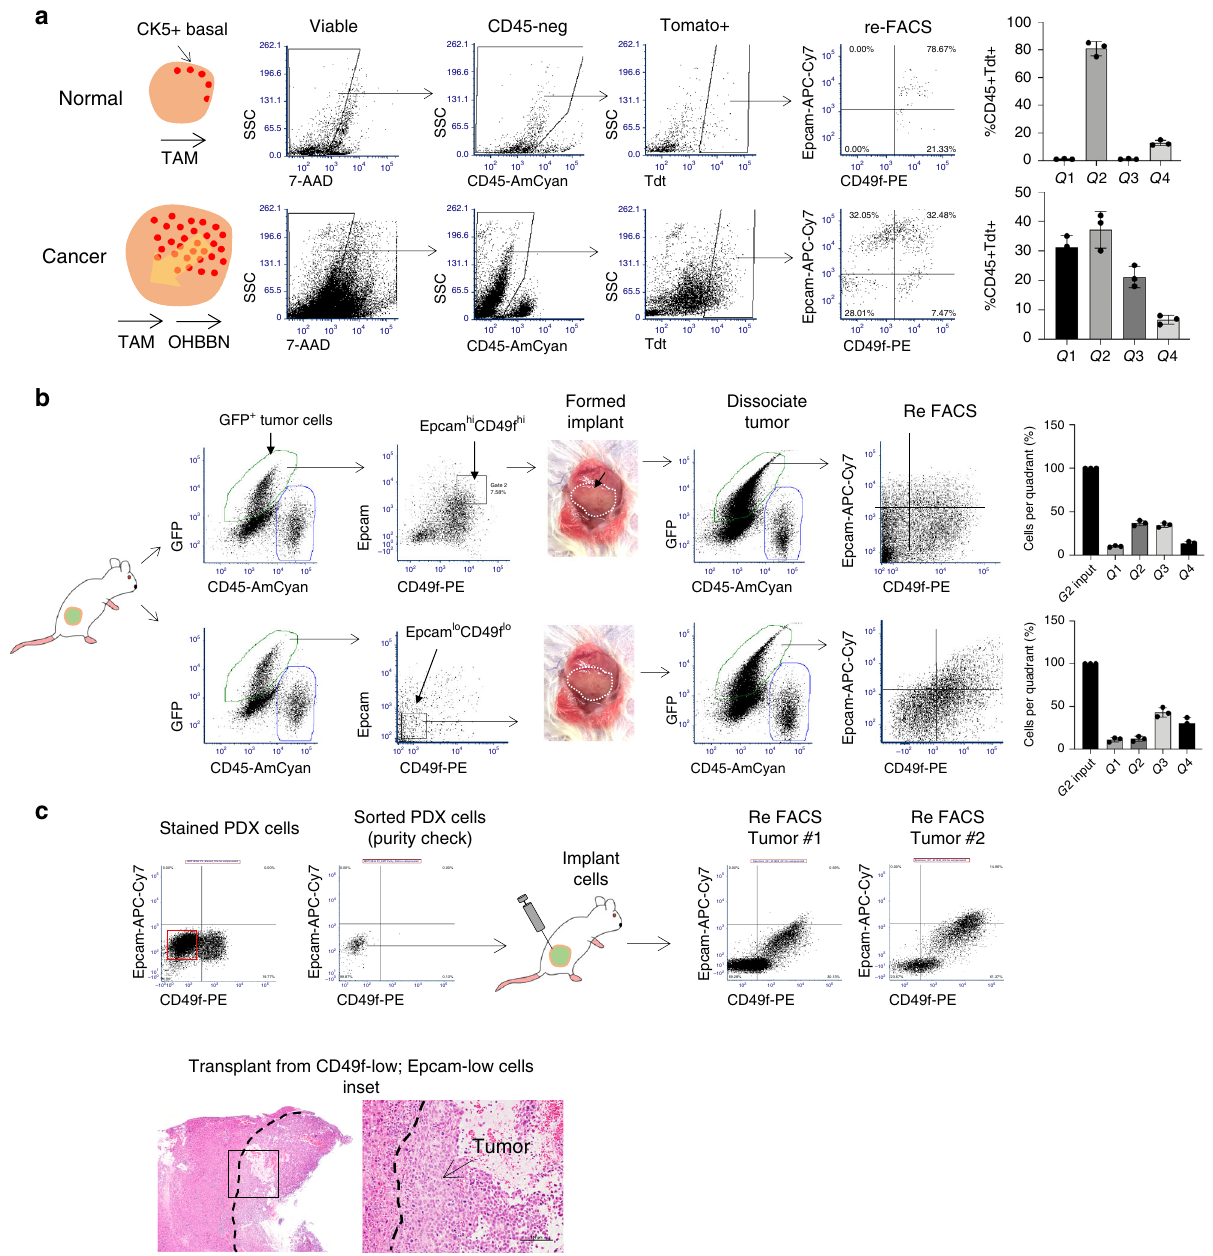
Fig. 7 Lineage plasticity of basal and mesenchymal tumor cell populations isolated from mouse and human bladder tumors. a Cytokeratin 5 tomato reporter ( KRT5 ERT2 -LSL ) mice showing that CK5-positive basal cells are enriched for CD49f expression in normal bladders (top). Subsequent to OHBBN- induced carcinogenesis, Tdt cells show heterogeneity in CD49f and Epcam expression (bottom). Right bar graphs, distribution of Tdt-positive;Epcam- CD49f-positive cells in normal and OHBBN-induced bladder cancer. b In-vivo transplantation of CD49f-high and CD49f-low tumor populations. Sorted and transplanted basal (GFP + Epcam high CD49f high ) cells or mesenchymal cell populations (GFP + Epcam low CD49f low ) were implanted to the bladder muscle wall of FVB mice and evaluated for tumor formation. Formed tumors were dissociated to single cells and assessed for redistribution of Epcam-CD49f expression according to the de fi ned quadrants (Q1, Q2, Q3, and Q4) after progression. c CD49f-low cells were isolated by fl ow cytometry from an early (P0) passage PDX model of MIBC (tumor 15934) followed by transplantation to immune compromised mice. Expression analysis of derived tumors under the same fl ow cytometry settings, shows marked redistribution and increased expression in CD49f ( n = 5). Lower, representative histology of resulting tumor outgrowths derived from CD49f low Epcam low cells (bar = 100 μ M). Individual data points are represented by circles, the error bars represent mean ± SD of the three independent replicates. Each experiment was performed at least six